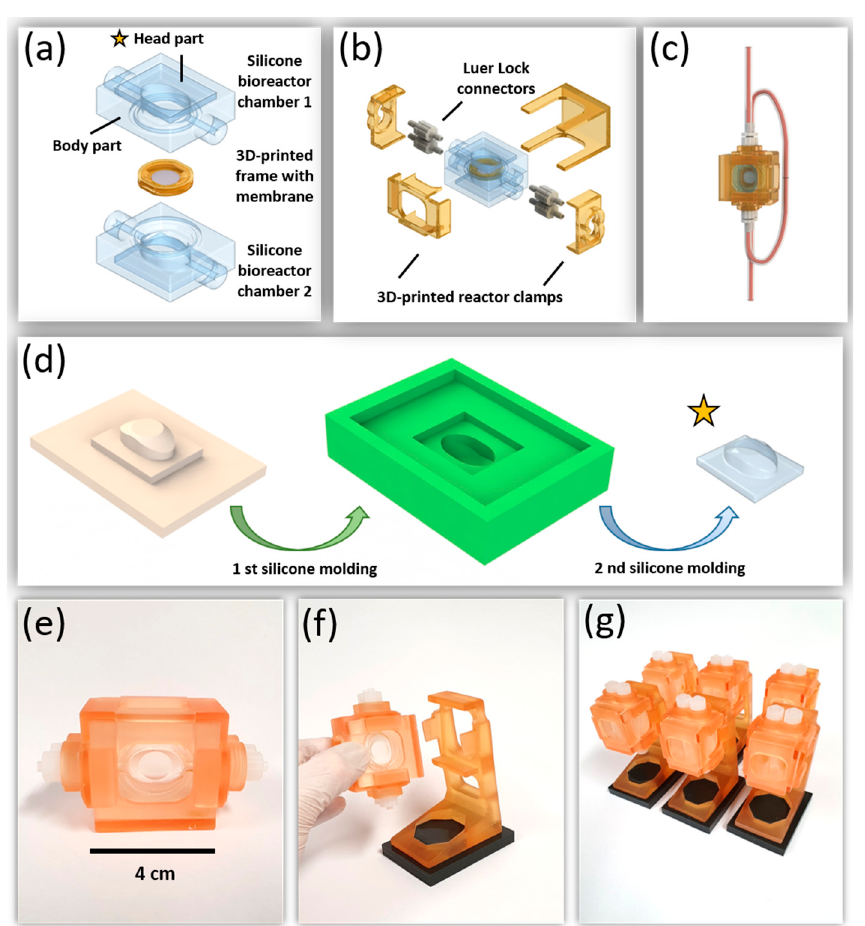
Figure 1. Design, fabrication process, and final realization of the chip bioreactor. ( a ) CAD image of the two bioreactor chambers, each comprising a bonded head and body part, together with the 3D-printed frame; ( b ) explosion view of the complete reactor with four 3D-printed clamps and Luer Lock connectors; ( c ) CAD image of the assembled bioreactor with attached tubing; ( d ) the silicone parts of the bioreactor are fabricated by a combination of 3D printing and two silicone molding steps. Head and body parts were then bonded by stick and stamp method (marked by yellow star) to create a bioreactor chamber; ( e,f ) photographs of the final bioreactor with and without holder; ( g ) parallelization of all the involved fabrication processes allowed fast small batch productions of the silicone bioreactors and the necessary equipment.